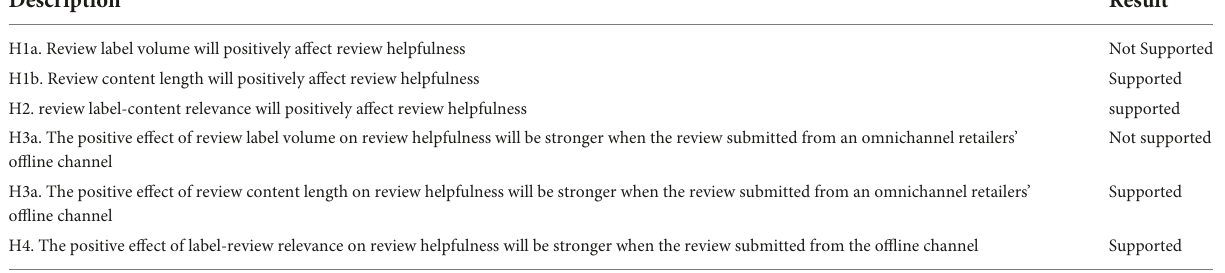
TABLE 3 The results of model